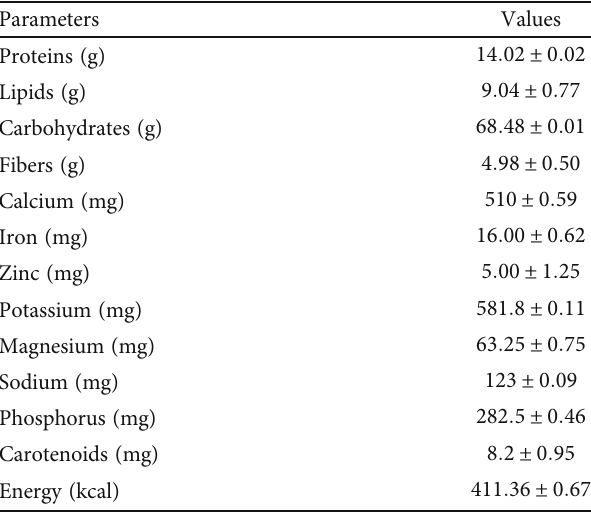
Table 5: Nutritional composition of the optimal infant fl